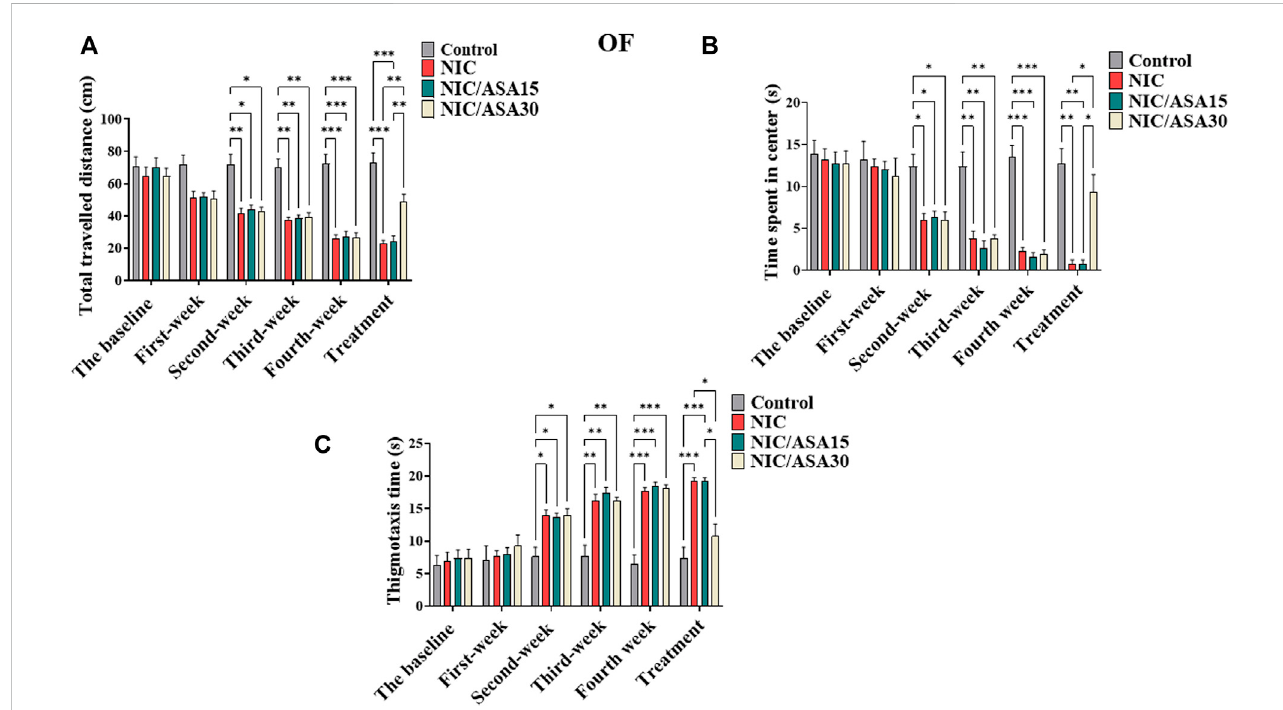
FIGURE 2 Behavioral testing inthe OF test(data are presented as mean ± SEM). (A) Distance traveled in the OFin Control,NIC, NIC/ASA15, and NIC/ASA30rats; (B) Time spent in the center of the OF in Control, NIC, NIC/ASA15, and NIC/ASA30 rats; (C) Thigmotaxis (time in the periphery of the open fi eld) in Control, NIC, NIC/ASA15, and NIC/ASA30 rats (* p < .05, ** p < .01, *** p < .001; n = 6 for each